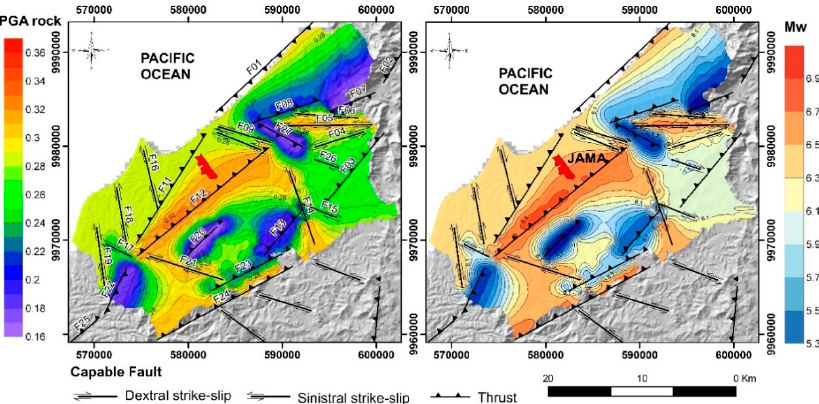
Figure 2. Map of maximum magnitudes ( left ) and PGA-rock determination ( right ) obtained from the analysis of capable geological faults in the canton of Jama. Table 2. List of the present geological faults and their parameters within the canton of Jama based on the Geological Faults Catalog.